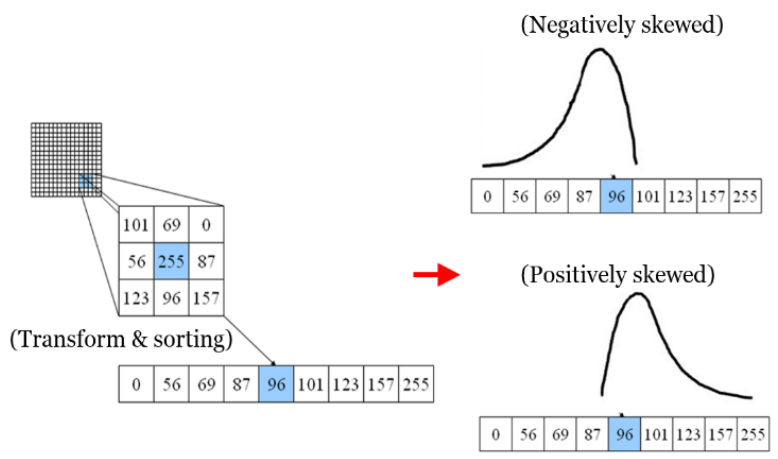
Figure 8. Example of skew-normal distribution weighted median filter.